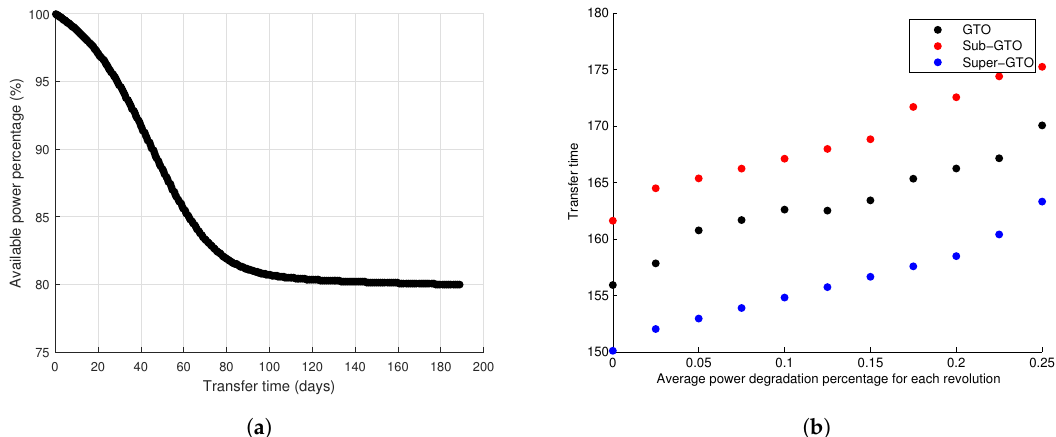
Figure 17. ( a ) power degradation predicted using neural network; ( b ) transfer time vs. average power degradation for each